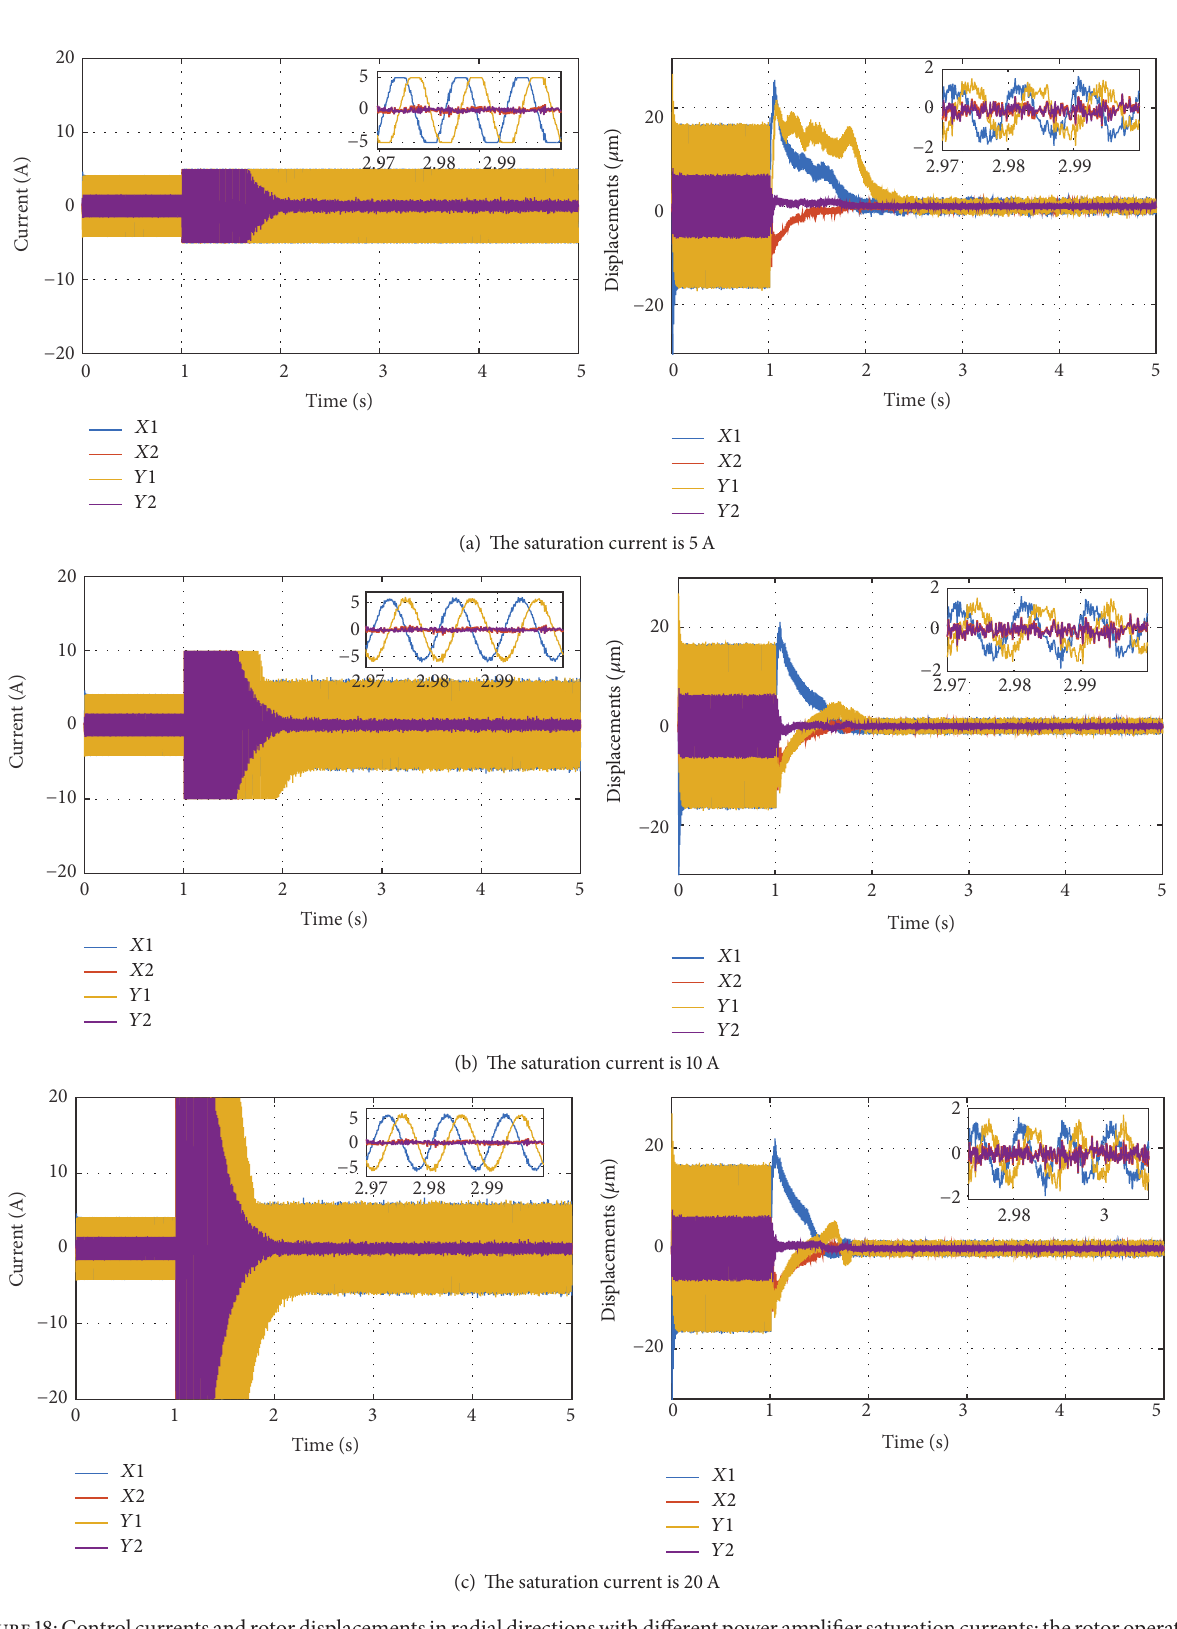
Figure18:Controlcurrentsandrotordisplacementsinradialdirectionswithdifferentpoweramplifiersaturationcurrents:therotoroperation speed is 6000